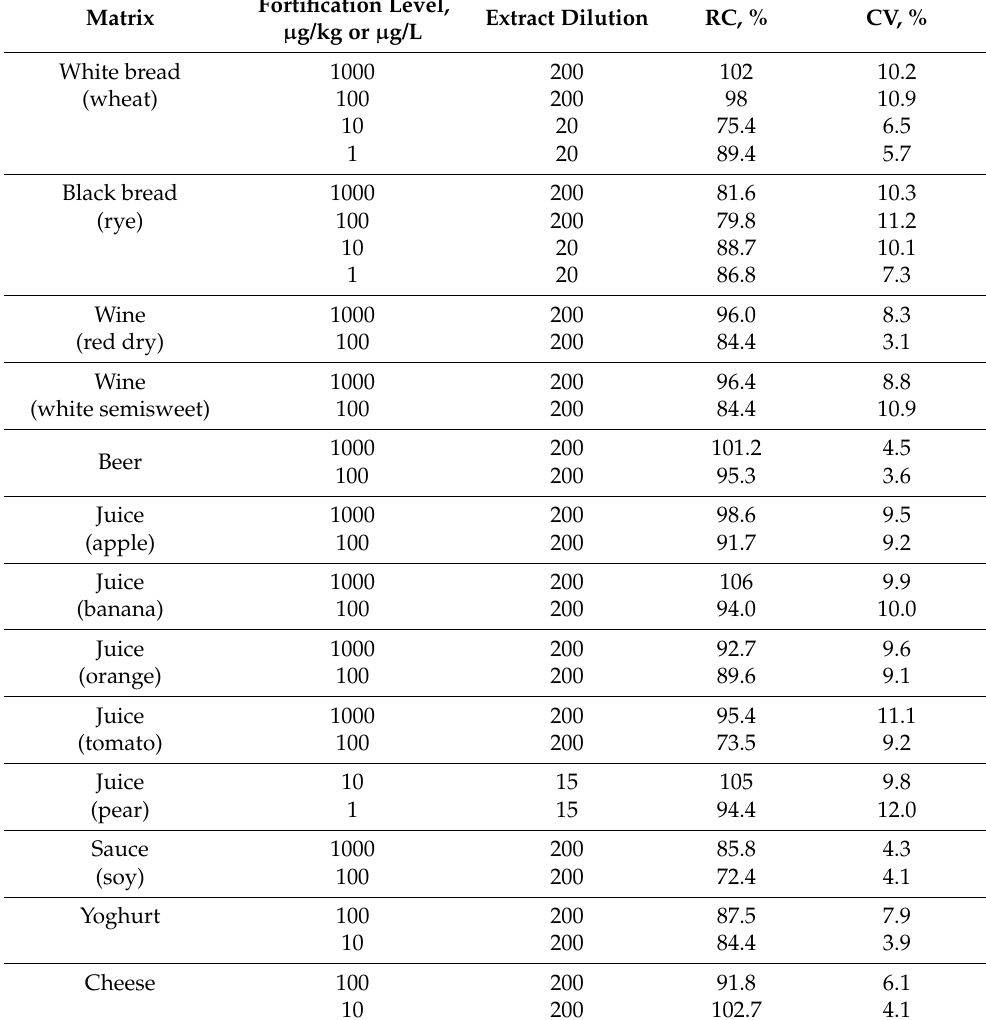
Table 3. Recovery of NAT from various food products and beverages using the developed ELISA. Fortification Matrix